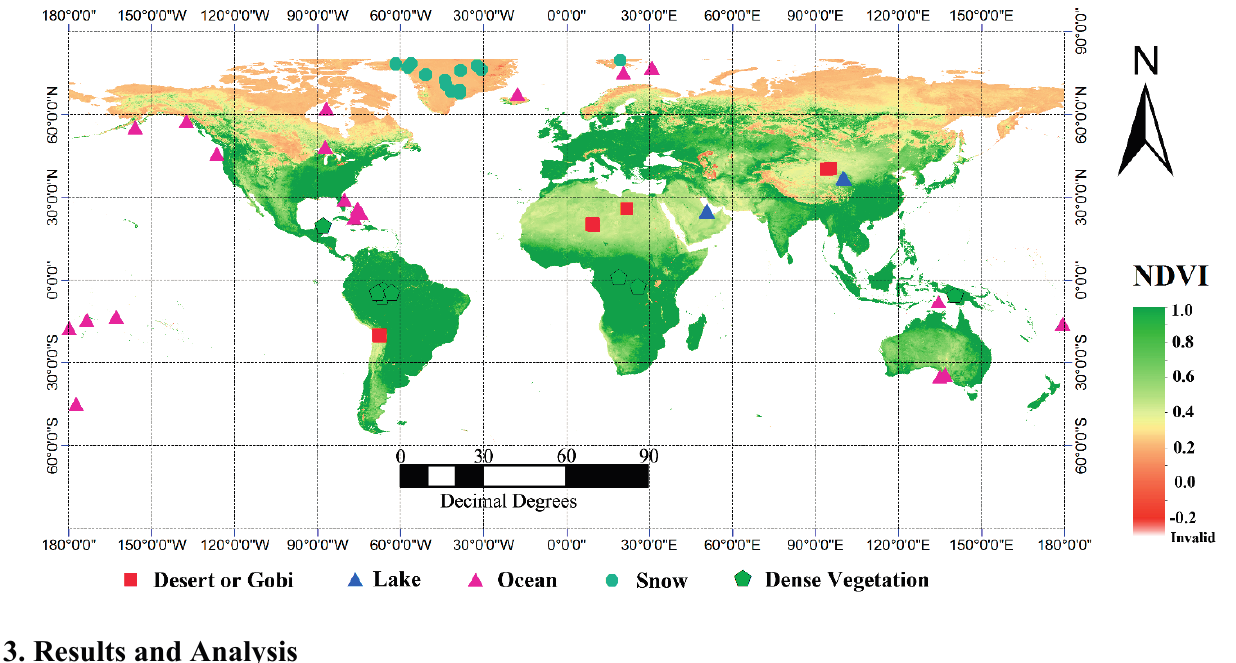
Figure 1. Distributions of the ground sites. The background image came from the MODIS global NDVI product at Day 257, 2013, with a spatial resolution of